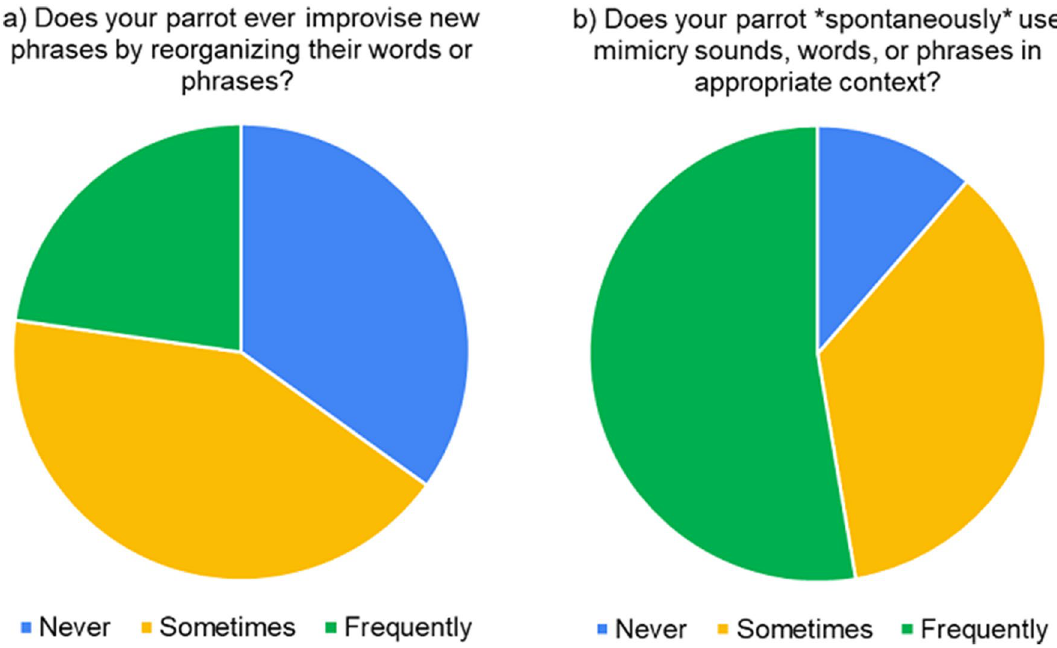
Figure 1. Rates of ( a ) vocal improvisation via word reorganization in phrases and ( b ) contextual use of mimicked vocalizations by companion parrots.